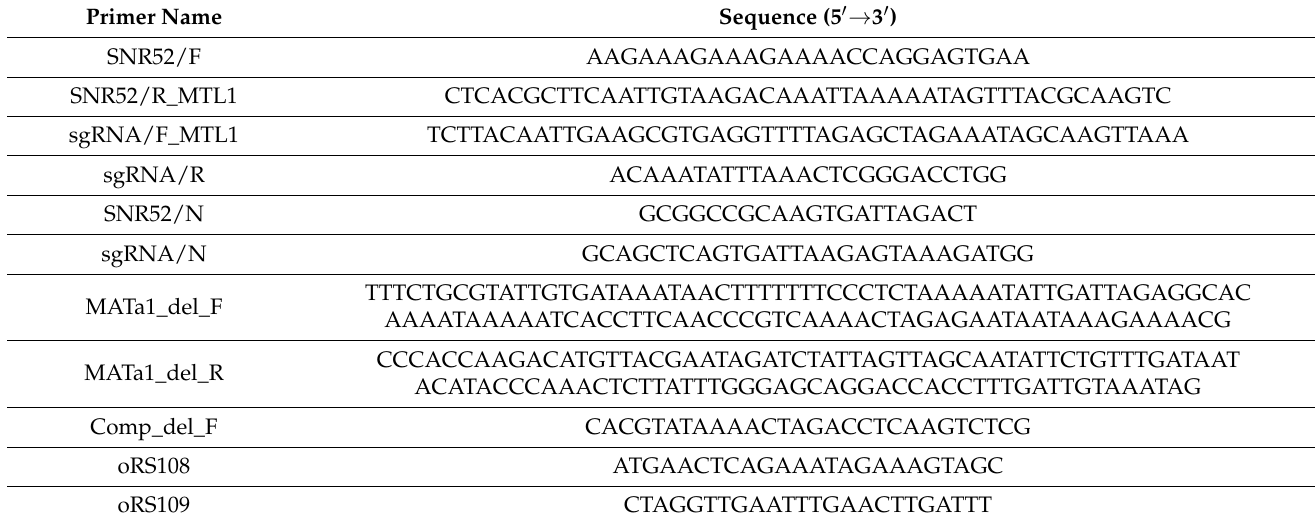
Table 2. Primers used in this